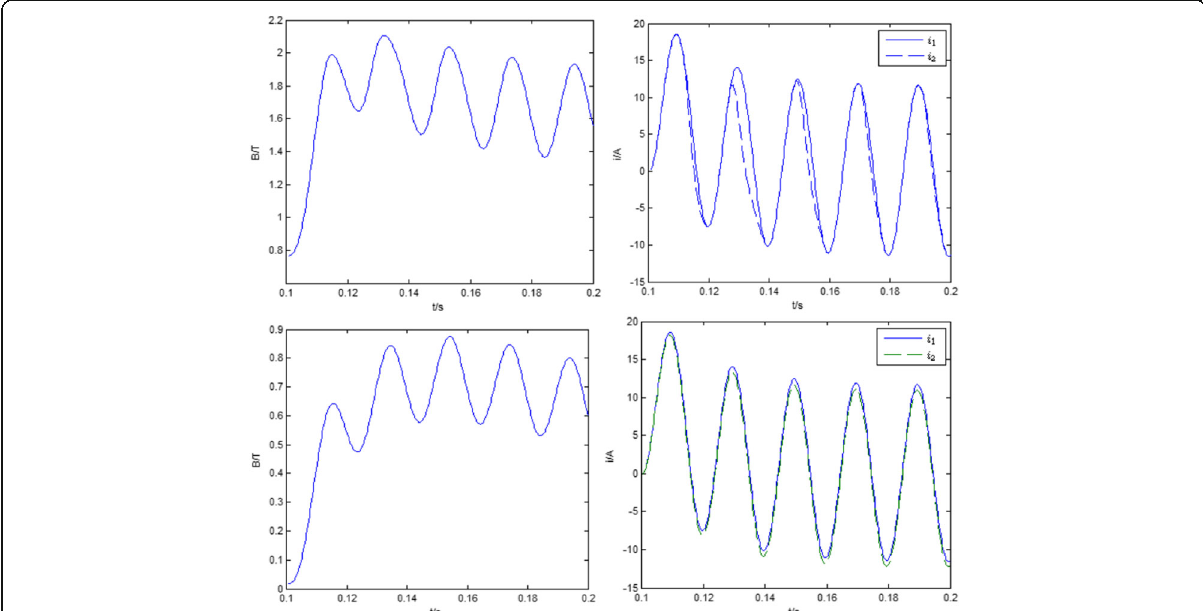
Fig. 14 50% remanence, magnetic flux generated at fault occurring time is